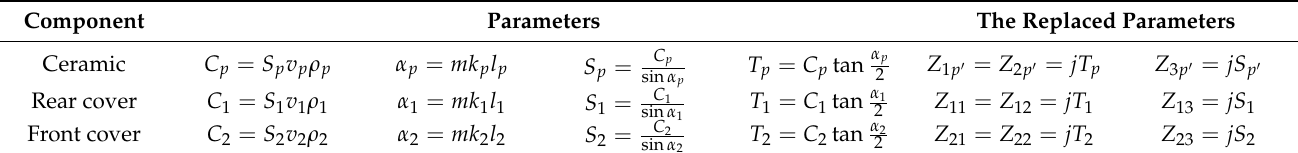
Table 2. The impedance of different